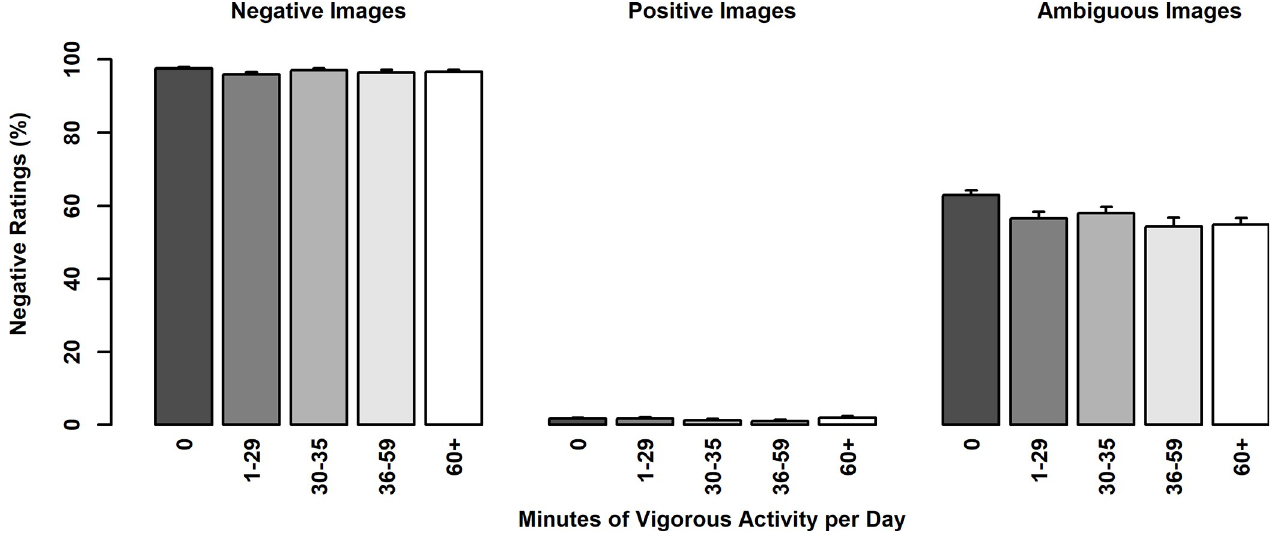
Fig 3. Percent negative ratings of emotional images as a function of vigorous activity in minutes per day. Ambiguous images were rated more positively by individuals that reported just a few minutes of vigorous activity per day as compared to those who reported no level of vigorous activity per day (p = .007).